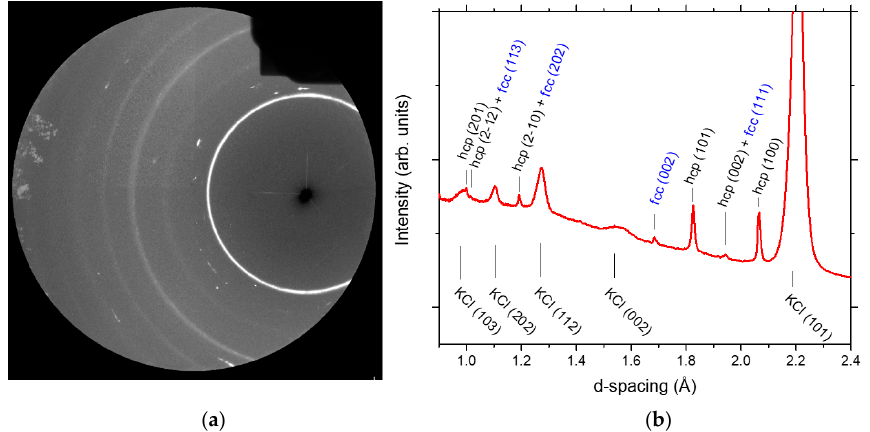
Figure 4. Example of the collected data at high pressure and high temperature. ( a ) 2D diffraction image and ( b ) integrated diffraction pattern of Fe–5Ni–5Si at 52 GPa and 1470 K.